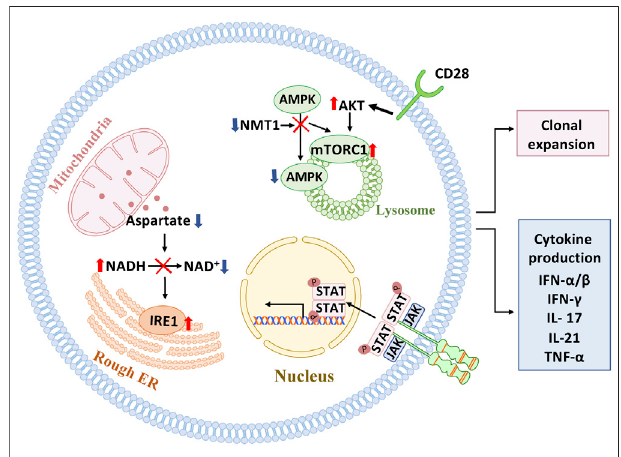
FIGURE 2 | Signaling pathways in pathogenic T cells. Several signaling pathways have been implicated in mediating pathogenic T cell function in autoimmune tissue in fl ammation. In the autoimmune disease rheumatoid arthritis (RA), which affects individuals with a prematurely aged immune system, mitochondrial-ER communication is faulty due to insuf fi cient generation of the amino acid aspartate, resulting in expansion of ER membranes and excessive production of the cytokine TNF-alpha. Also, in RA T cells, mitochondrial repair is impaired due to lacking activation of AMPK and unopposed activation of mTORC1 on the lysosomal surface. Mistraf fi cking of AMPK to the lysosome is a consequence of insuf fi ciency in the enzyme N-myristoyltransferase 1(NMT1), which is responsible for posttranslational modi fi cation of AMPK. In giant cell arteritis, a strictly aging-associated autoimmune and autoin fl ammatory disease, persistent signaling through the JAK/STAT pathway and the CD28 pathway have been mechanistically connected to pathogenic immune responses in the in fl amed